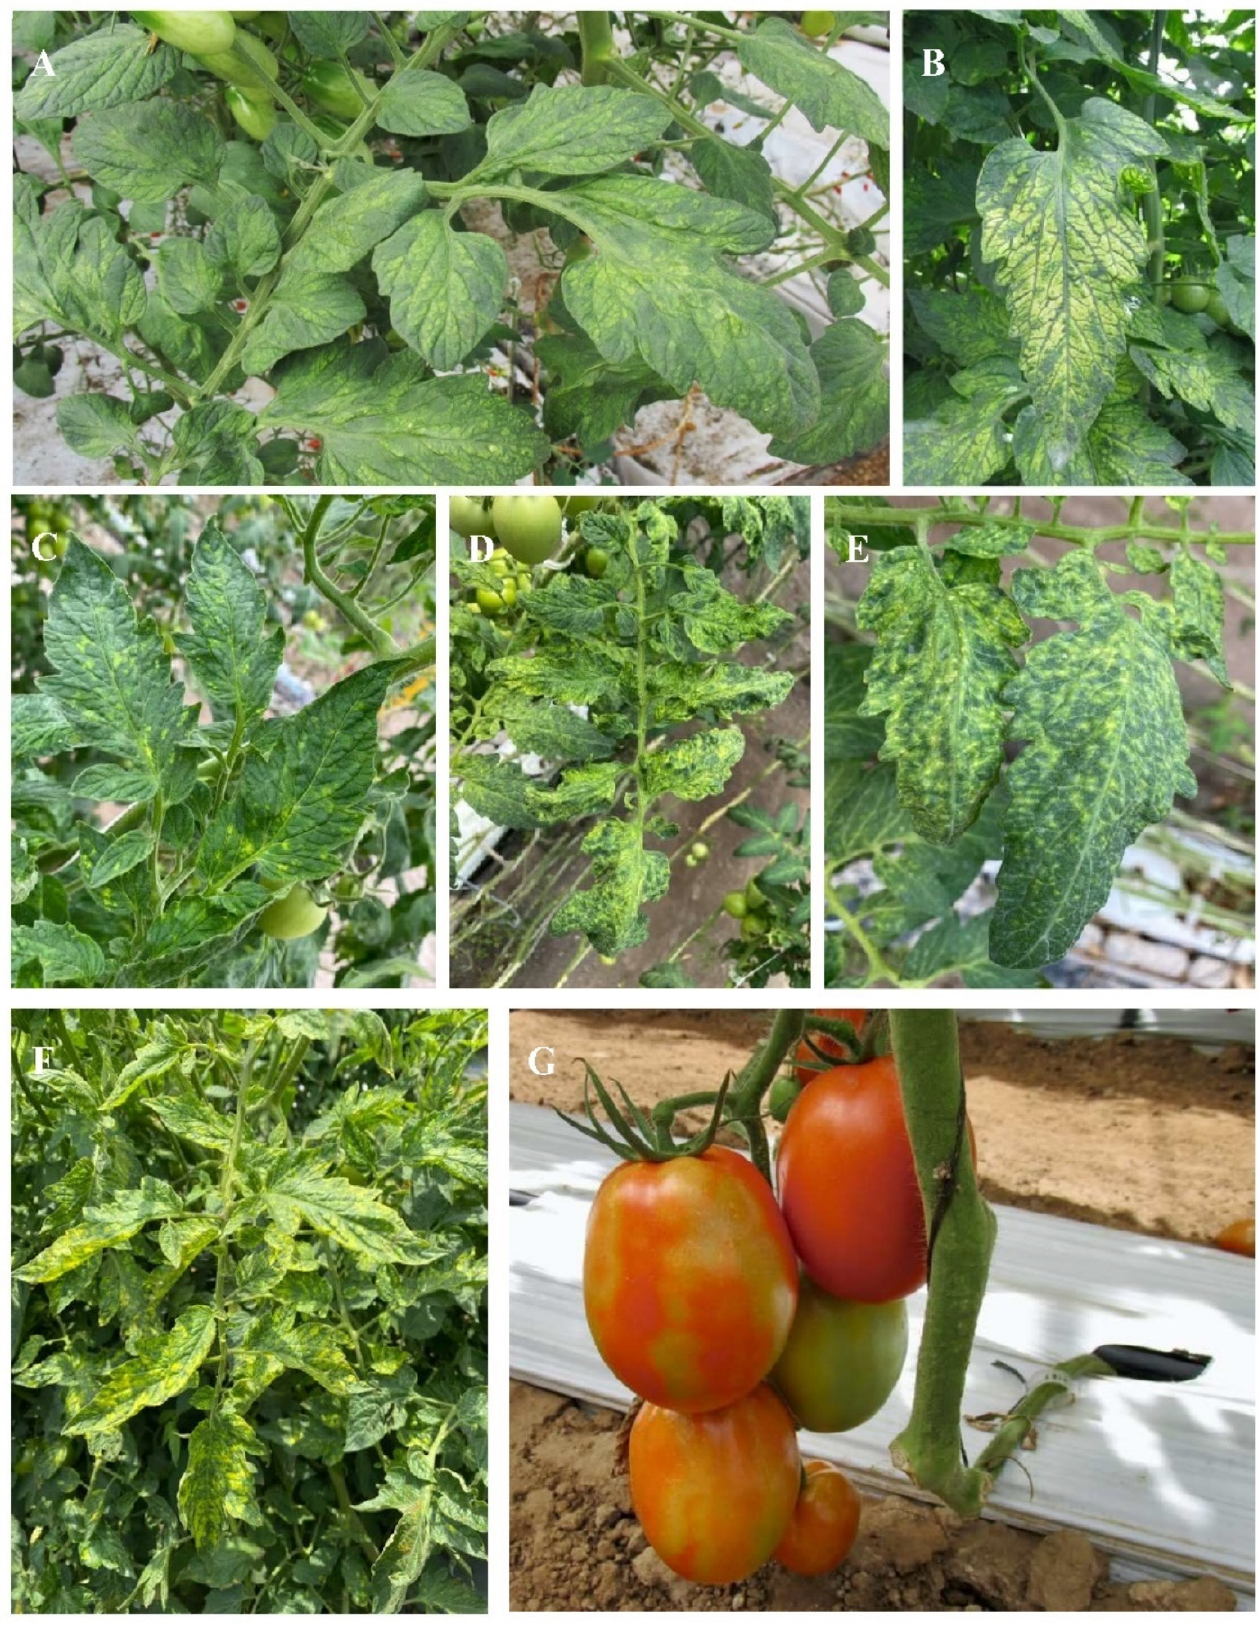
Figure 4. Symptoms caused by pepino mosaic virus on tomato plants. ( A – F ) Mosaic patterns and yellow spotting in leaves. ( G ) Fruits with yellow spots (mottle).